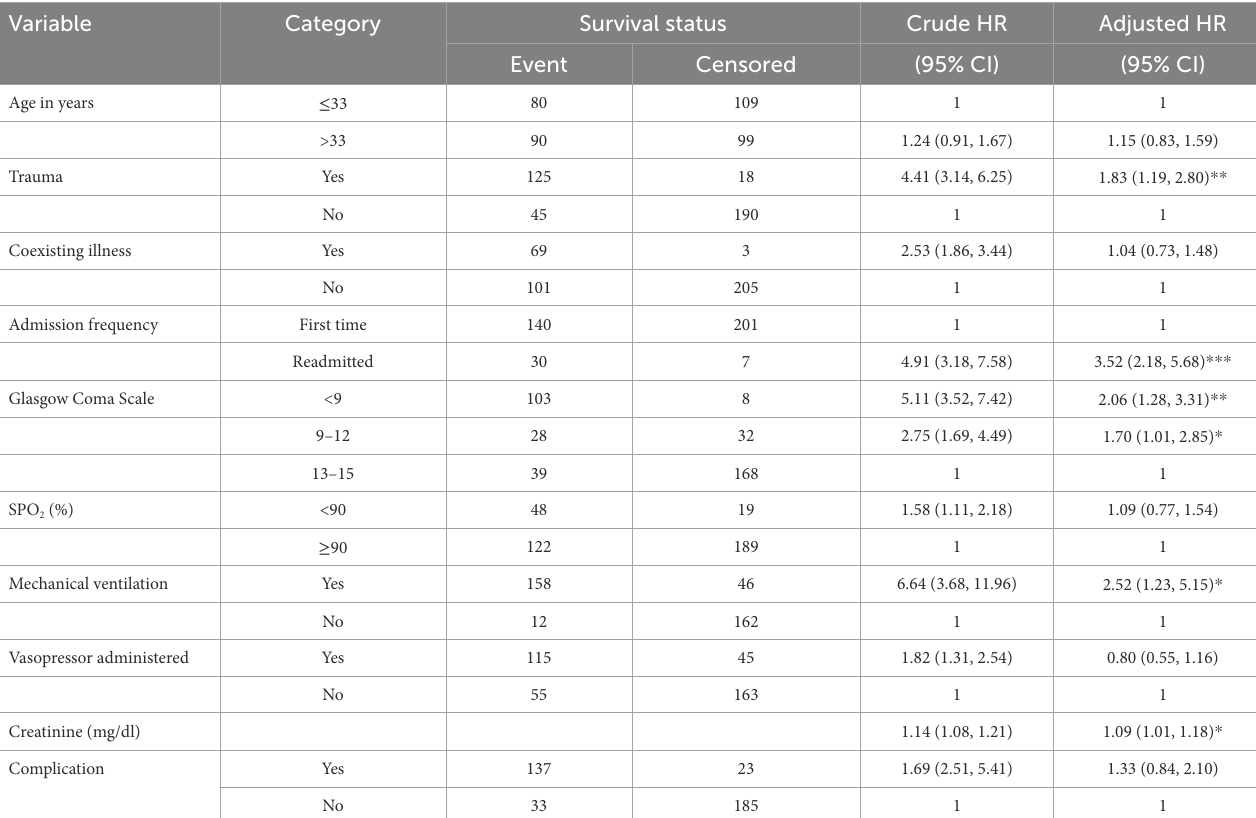
TABLE 2 Multivariable Cox regression analysis for mortality predictors among surgical patients admitted to the SICU, Addis Ababa, Ethiopia, February 2017 – February 2020.